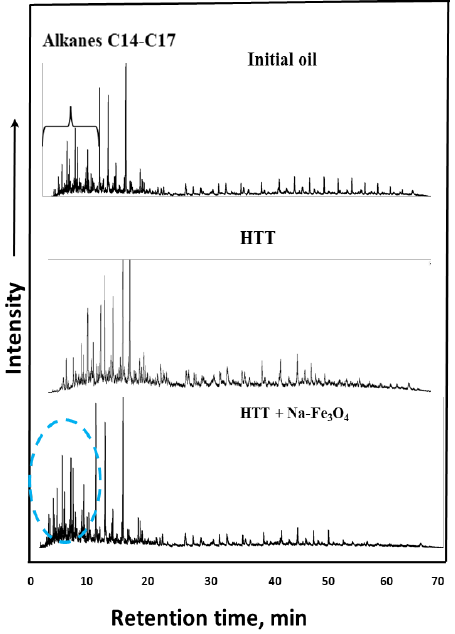
Figure 11. GC-MS spectra of saturated hydrocarbons by m / z = 57.